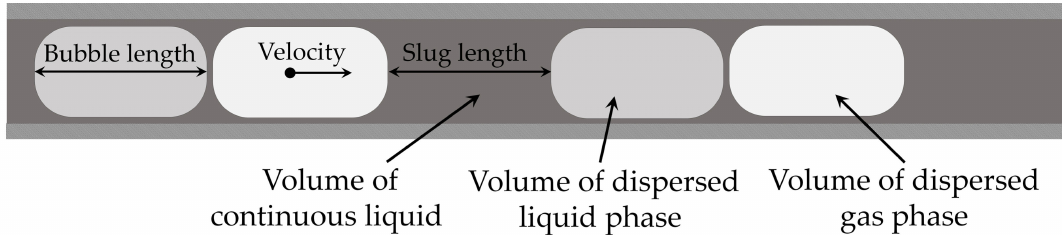
Figure 1. Schematic of a triphasic slug flow with two liquid components and one gaseous